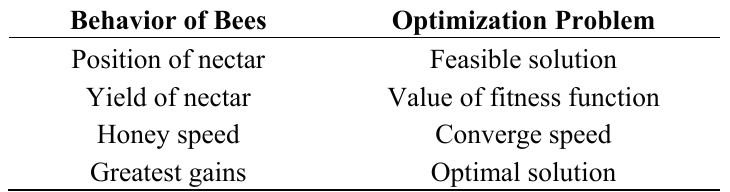
Table 1. Relationship between the behavior of bees and the optimization